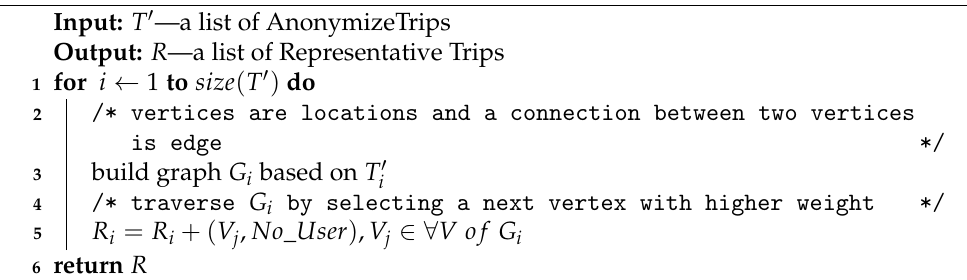
Algorithm 6: Trip Publication Component in